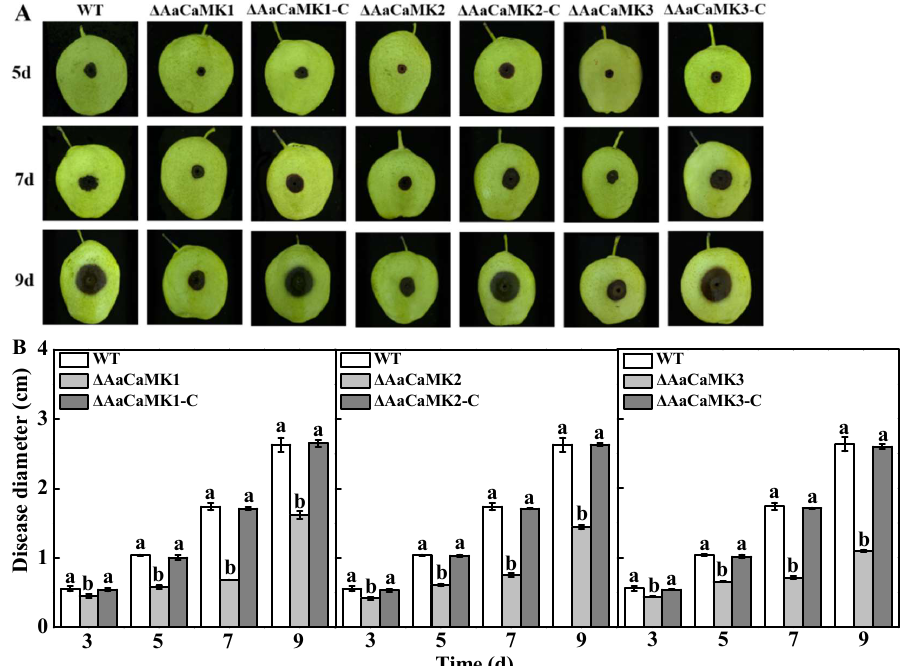
Figure 9. The disease progression ( A ) and lesion diameter ( B ). Means and standard deviations were calculated from three replicates. Different letters in the graph indicate statistical differences ( p < 0.05). 2.7. AaCaMKs Regulate the Melanin Content of A. alternata The intracellular melanin content of Δ AaCaMK1 and Δ AaCaMK3 were significantly higher than WT. While the intracellular melanin content in Δ AaCaMK2 was not signifi- cantly changed, the melanin contents of Δ AaCaMK1 and Δ AaCaMK3 were significantly increased by 39 and 75%, respectively, compared to the WT (Figure 10A). In contrast, the extracellular melanin content of ΔAaCaMKs was significantly lower than WT. Precisely, the melanin content of Δ AaCaMK1 and Δ AaCaMK2 was decreased by 47 and 59%, respec- tively (Figure 10B). These results imply that AaCaMKs regulate the melanin content in A. alternata . Figure 10. A. alternata melanin content. ( A ) The intracellular melanin content in WT, Δ AaCaMK1, Δ AaCaMK2 and Δ AaCaMK3. ( B ) The extracellular melanin content in WT, Δ AaCaMK1, Δ AaCaMK2 and Δ AaCaMK3. Bars represent standard deviations of means of three replicates. Different letters in the graph indicate statistical differences ( p < 0.05). 3. Discussion CaMK is a serine/threonine protein kinase that plays significant and conserved roles in regulating growth, conidial germination, appressorium formation, stress response and pathogenicity in many fungal pathogens. For example, CaMK regulates conidial germina- tion, appressorium formation, melanin production and pathogenicity in M. oryzae [25,26]. In addition, the deletion of the CaMK gene in Aspergillus nidulans caused a defect in nu- clear division and spores germination; thus, the disruption of CMKB is lethal [27]. Recent